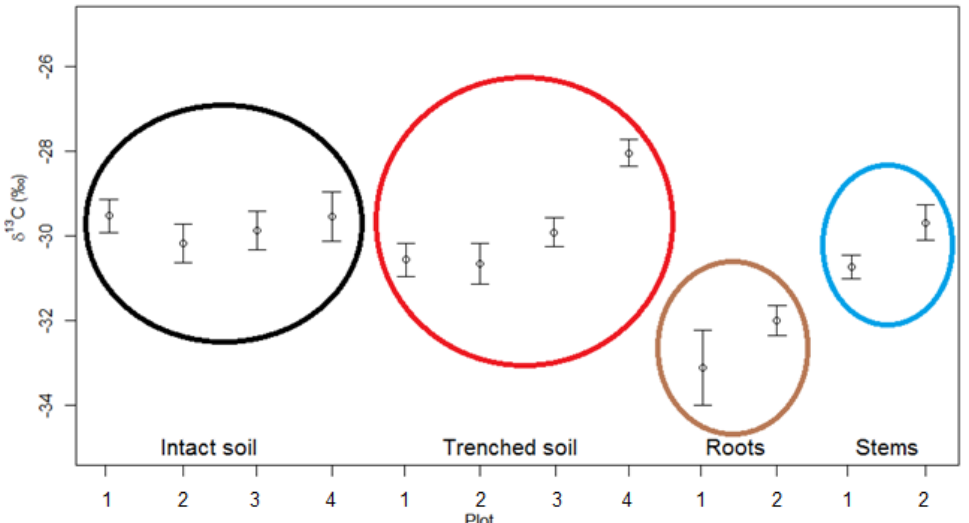
Figure 6. Mean δ 13 C of the CO 2 fluxes determined by Keeling plots (± standard deviation) for each of the 12 plots throughout the measurement period. The plots are shown from left to right in the